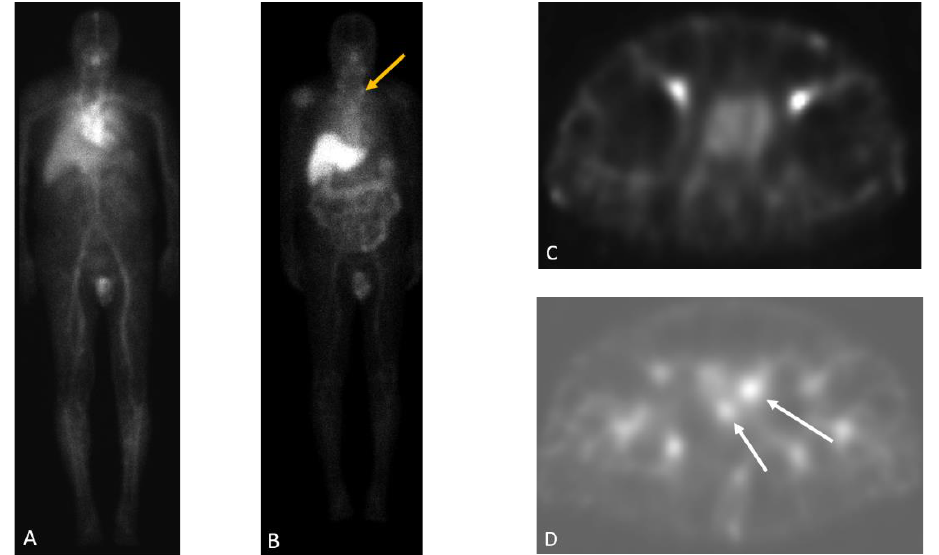
Figure 2. Sixty-four-year-old man with history radical prostatectomy for prostate cancer (Gleason 4 + 4) with rising PSA. In111 capromab pendetide whole body blood pool ( A ) and 96 h delayed ( B ) images demonstrate a focus of increasing radiotracer activity in the left neck base corresponding to a metastatic supraclavicular (Virchow) node (yellow arrow in B ). SPECT blood pool ( C ) and delayed ( D ) images of the pelvis demonstrate two foci of increasing radiotracer activity in the right and left prostate bed, compatible with local recurrence (white arrows).